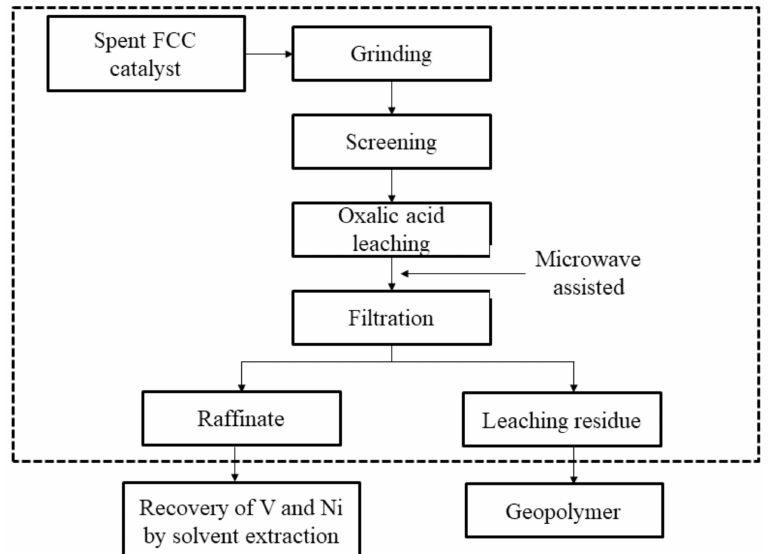
Figure 1. Flow diagram of the simultaneous recovery of V and Ni from the SFCC